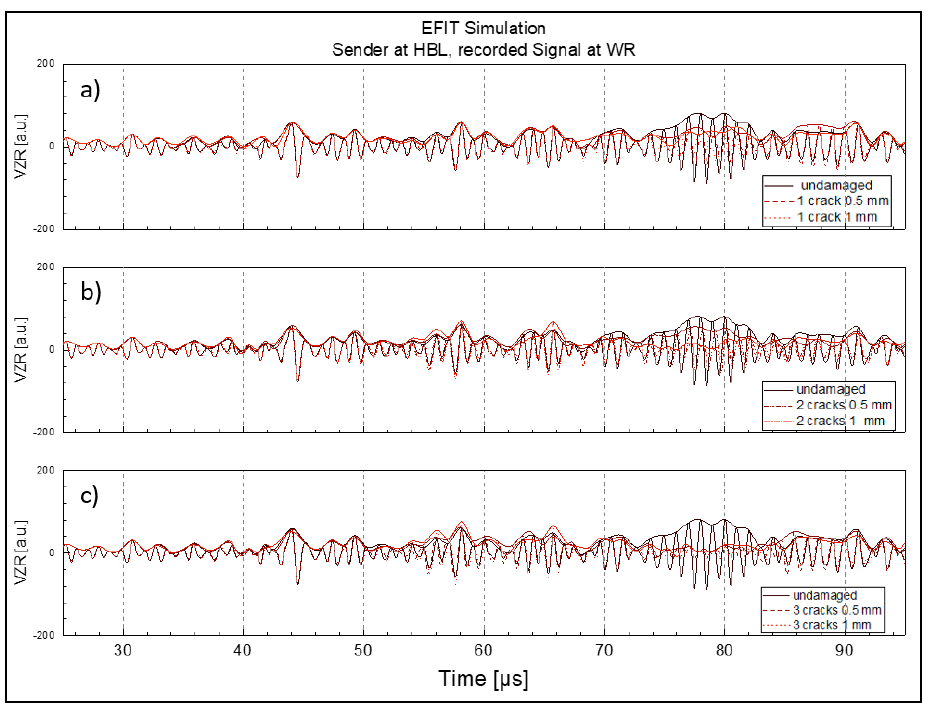
Figure 13. Change of transmitted R-wave received at position WR with increasing number of cracks and crack depths up to 1 mm; ( a ) 1 crack ( b ) 2 cracks ( c ) 3 cracks.